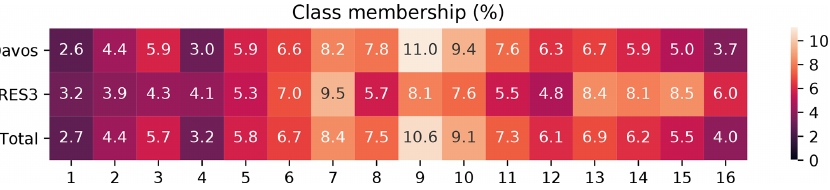
Different applications may require different